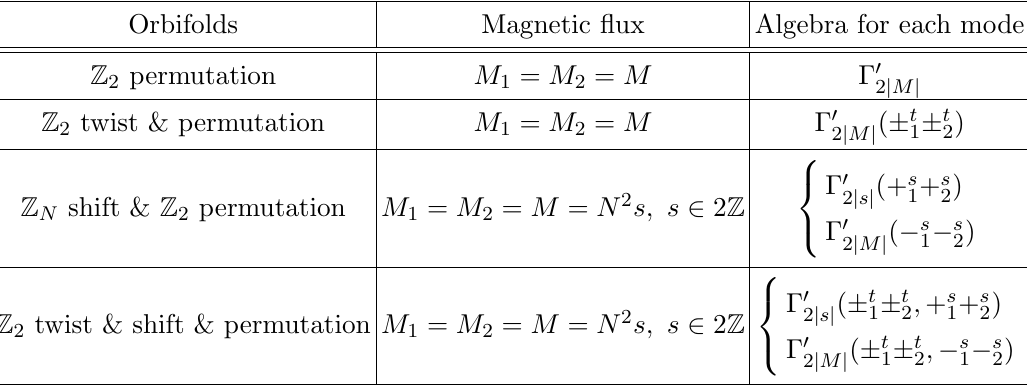
(cid:2) T 2 ) = Z N twist, shift 1 2